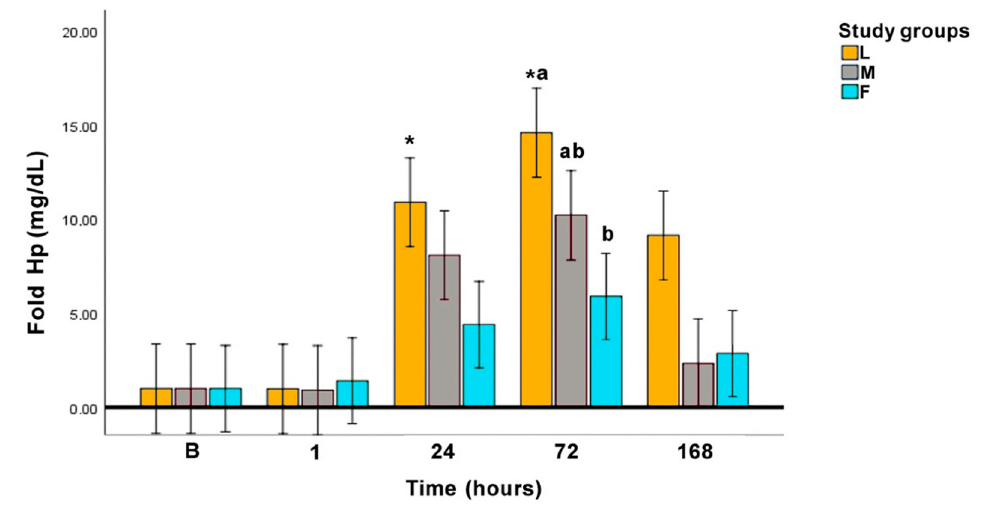
Figure 3. Fold Hp concentration along the experimental period. L: laparoscopic OVE, M: midline OVE, and F: flank OVE. Different letters (a, b) indicate differences between groups. B: baseline, * p < 0.05: statistically significant difference compared to baseline.